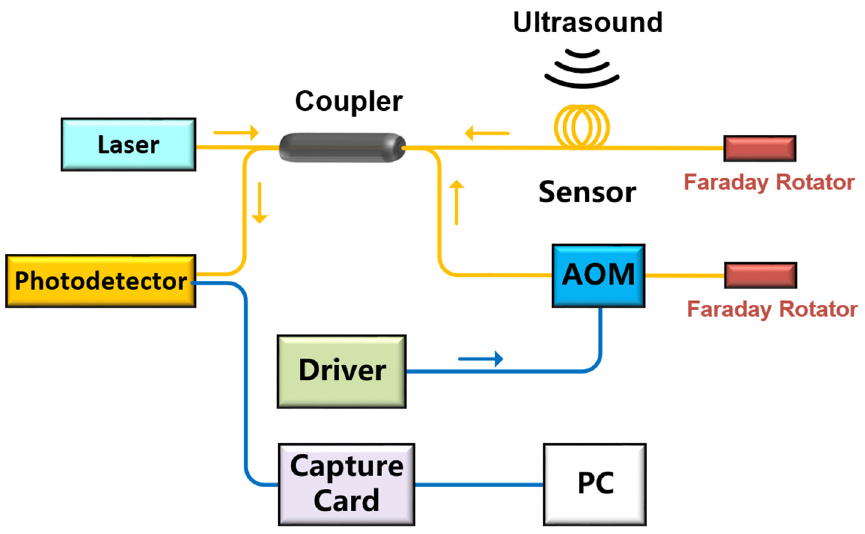
Figure 6. The structure of the interference ultrasonic sensing system based on an AOM high frequency carrier phase demodulator.